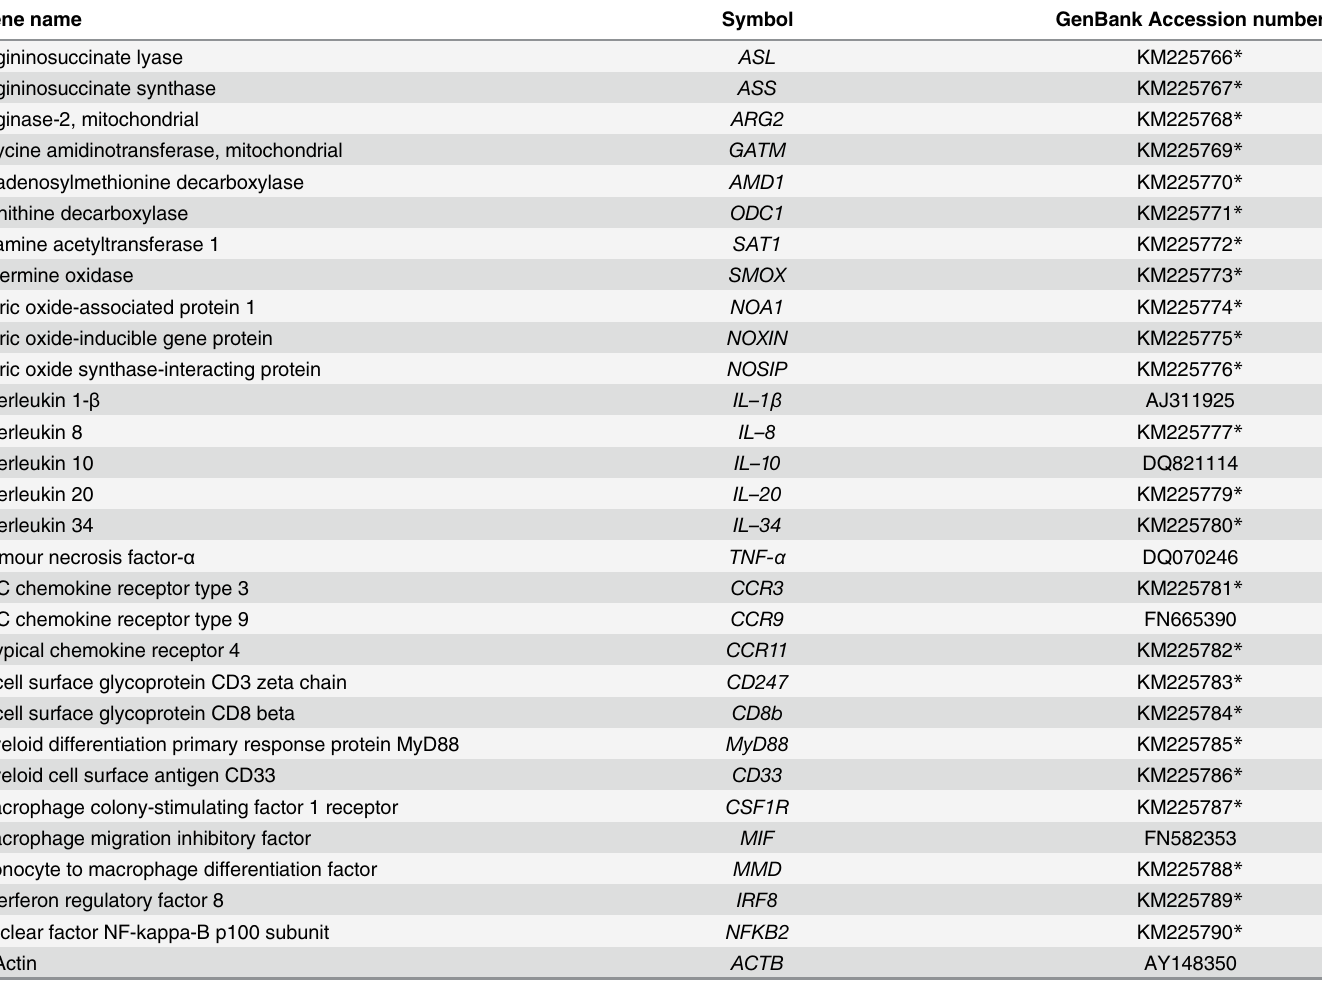
(Table 3). Among the 30 genes, 24 genes were novel for European sea bass and their sequences, derived from the IATS-Nutrigroup transcriptomic database (www.nutrigroup-iats.org/ seabassdb), were uploaded to GenBank (KM225766-KM225790, S1 Table). Controls of general PCR performance were included on each array, being performed all the pipetting operations by means of the EpMotion 5070 Liquid Handling Robot (Eppendorf, Hamburg, Germany). Briefly, RT reactions were diluted to convenient concentrations and the equivalent of 660 pg of total input RNA was used in a 25 μ L volume for each PCR reaction. PCR-wells contained a 2× SYBR Green Master Mix (Bio-Rad) and specific primers at a final concentration of 0.9 μ M were used to obtain amplicons of 50 – 150 bp in length (S2 Table). The program used for PCR amplification included an initial denaturation step at 95°C for 3 min, followed by 40 cycles of denaturation for 15 s at 95°C and annealing/extension for 60 s at 60°C. The efficiency of PCR reactions was always higher than 90%, and negative controls with- out sample templates were routinely performed for each primer set. The specificity of reactions was verified by analysis of melting curves (ramping rates of 0.5°C/10 s over a temperature Table 3. Immune-related genes analysed by real-time